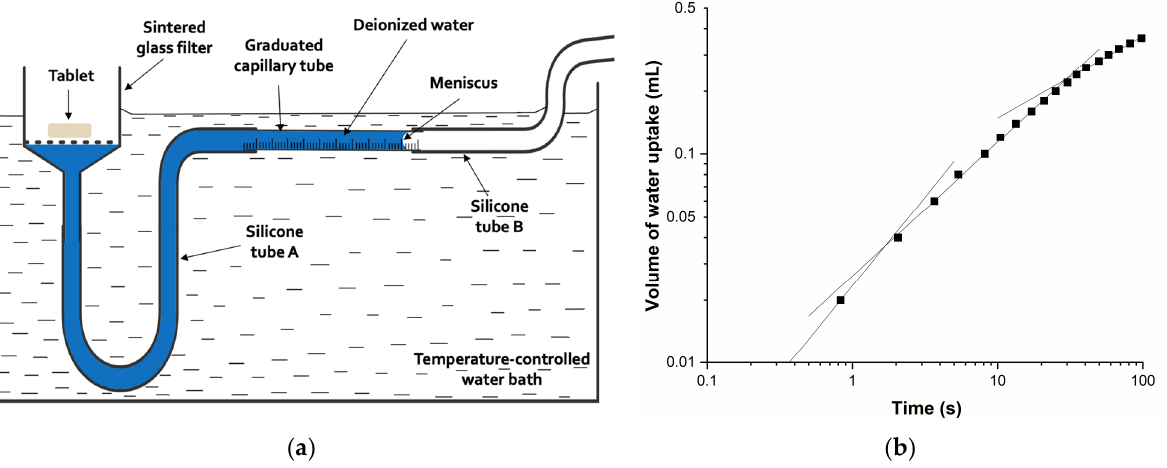
Figure 1. ( a ) Schematic diagram of the liquid penetration test apparatus, and ( b ) example of the double logarithmic water uptake plot with three linear portions.